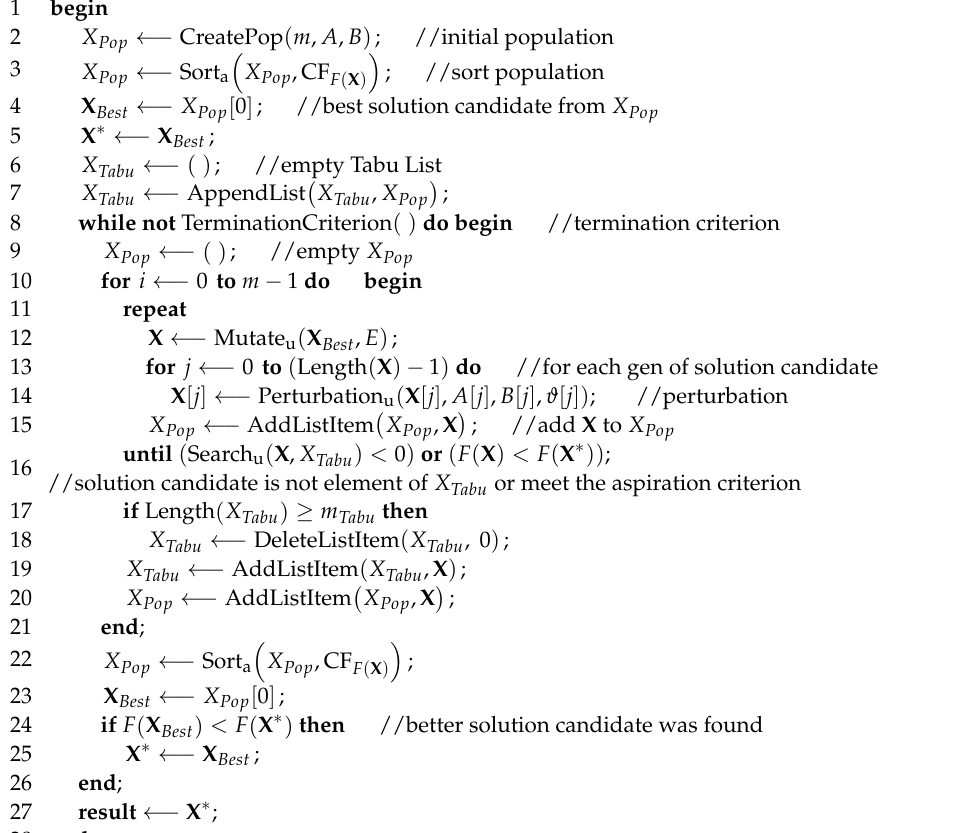
Algorithm 4: Stochastic Tabu Search